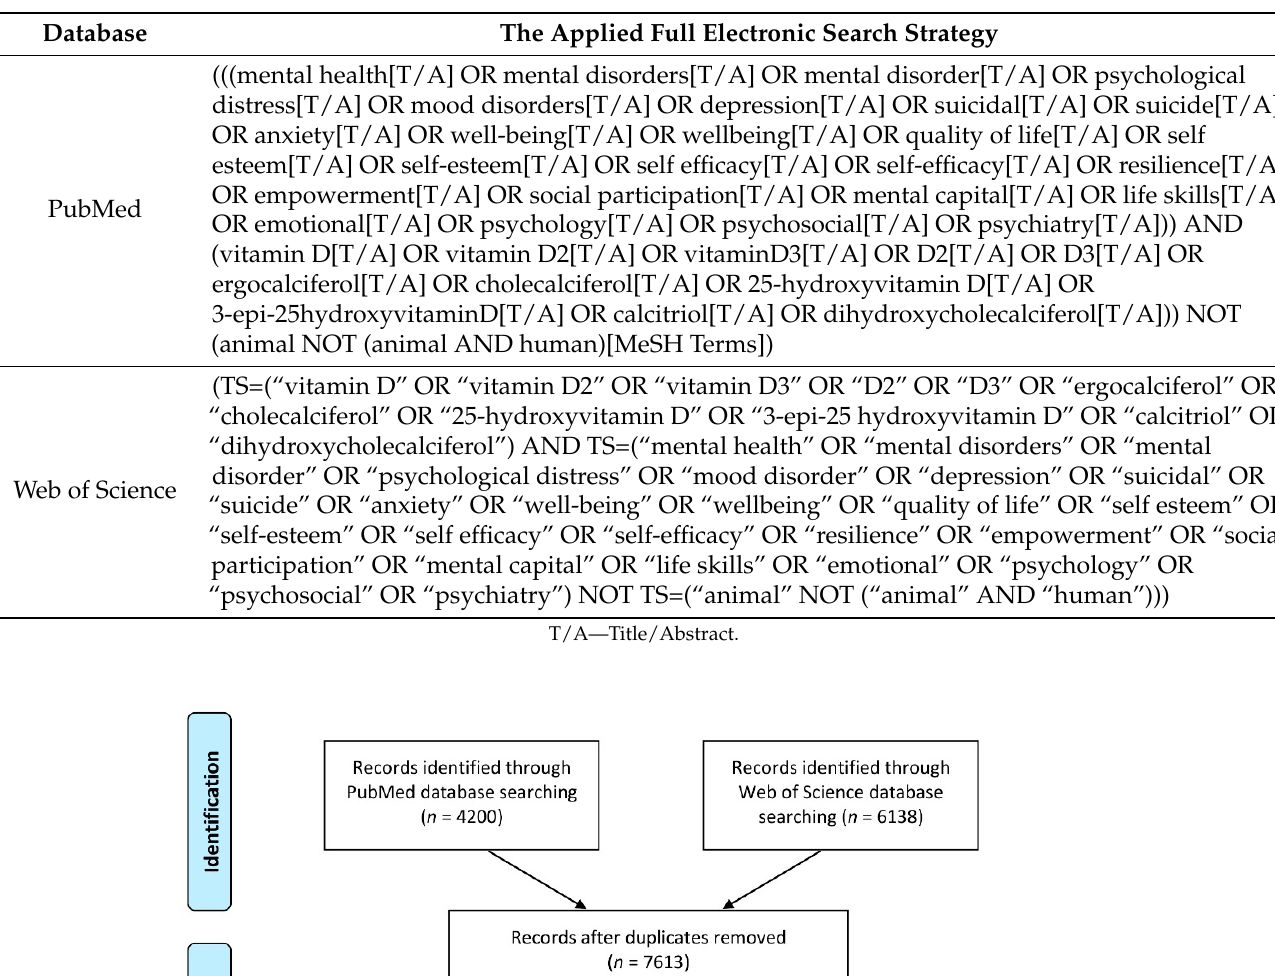
Table 1. The applied detailed electronic search strategy for databases of PubMed and Web of Science.